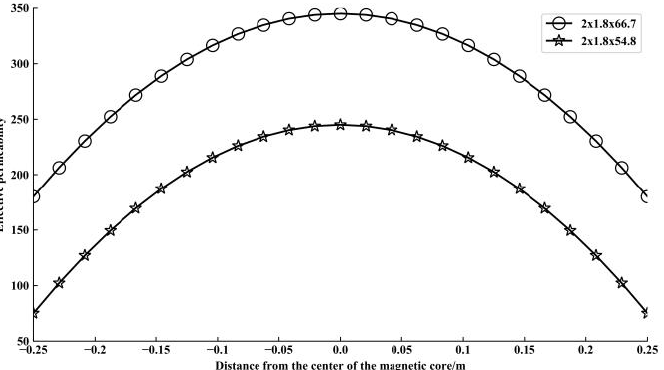
Figure 2. The simulation curves of the apparent permeability distribution for the rectangular cores with different sized flux concentrators.